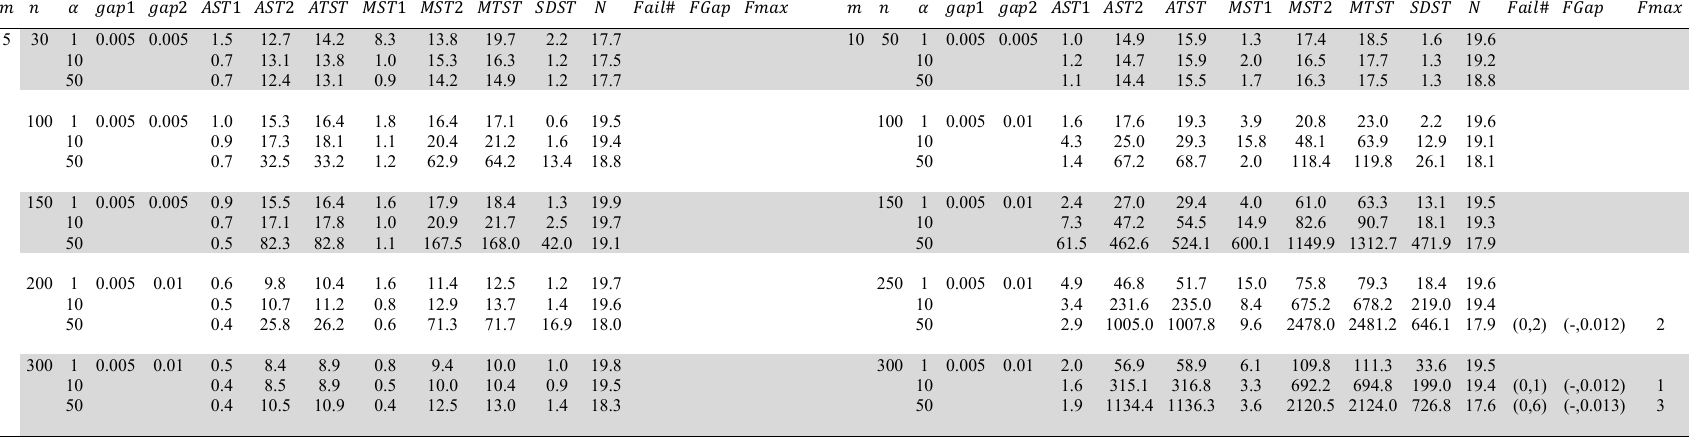
Experimental results of applying the MILP solution procedure for the problem instances with 5 and 10 machines 𝑚 𝑛